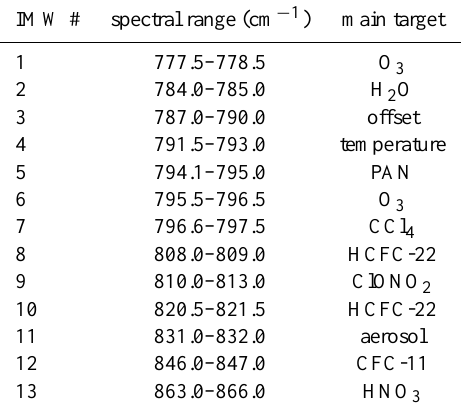
Table 1. Integrated micro windows (IMW) as used in the retrieval and the corresponding main retrieval